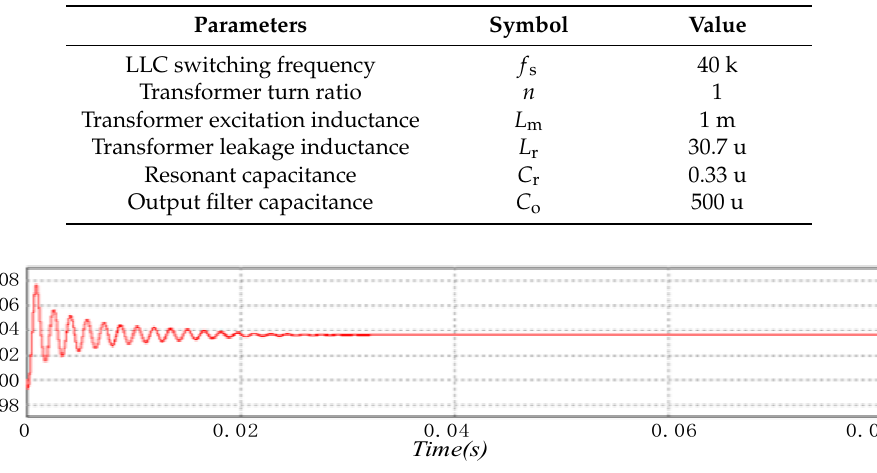
Figure 15. LLC resonant converter output simulation curve.